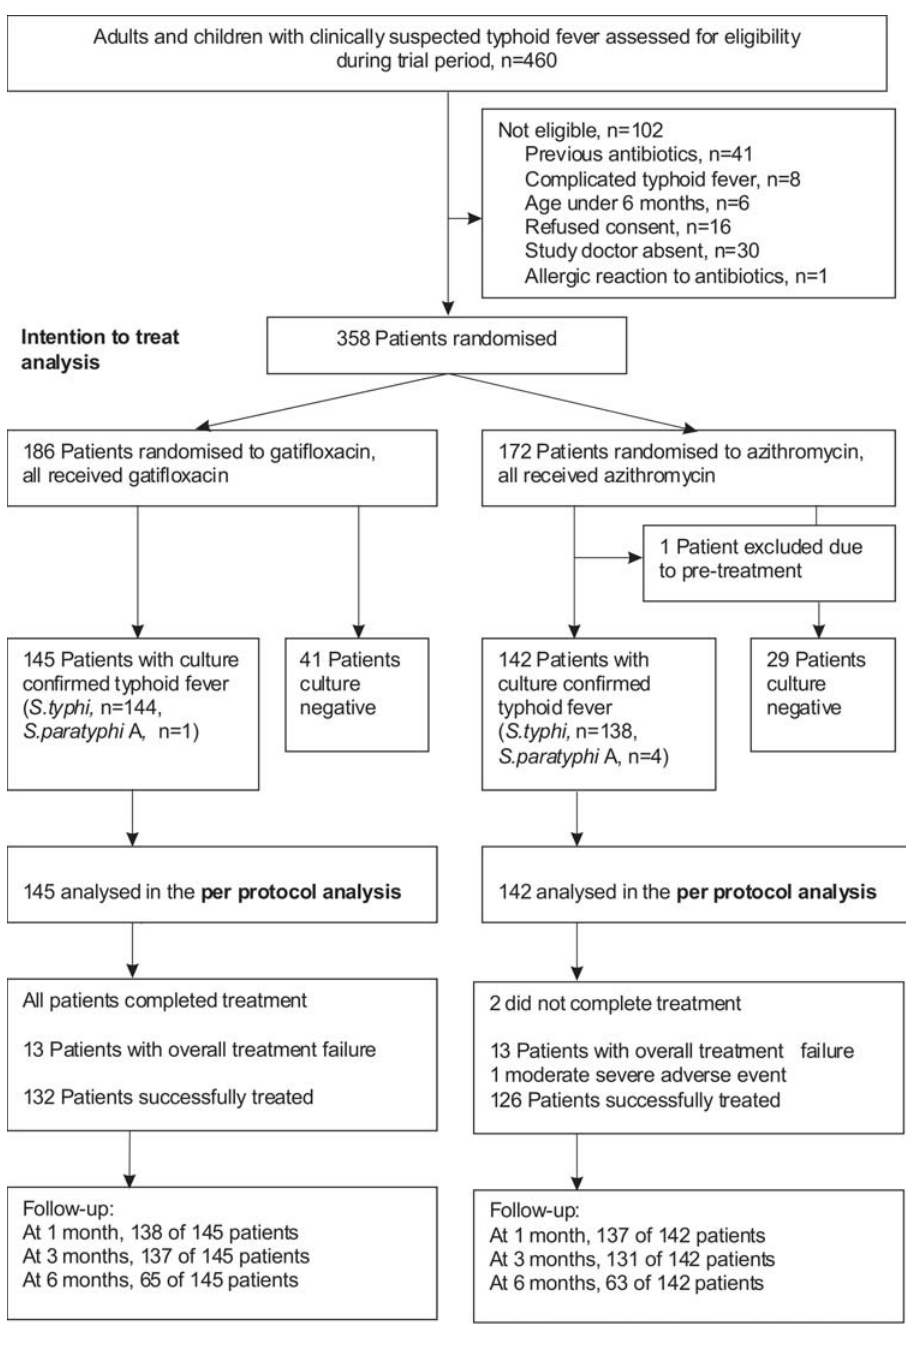
Figure 1. Profile of the Trial.